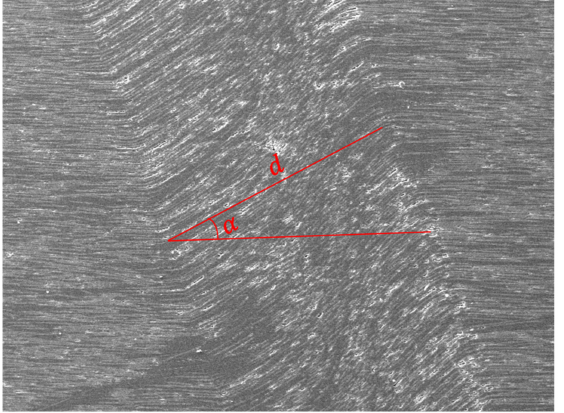
Figure 7. Measurement of the kink-band width and incline angle.